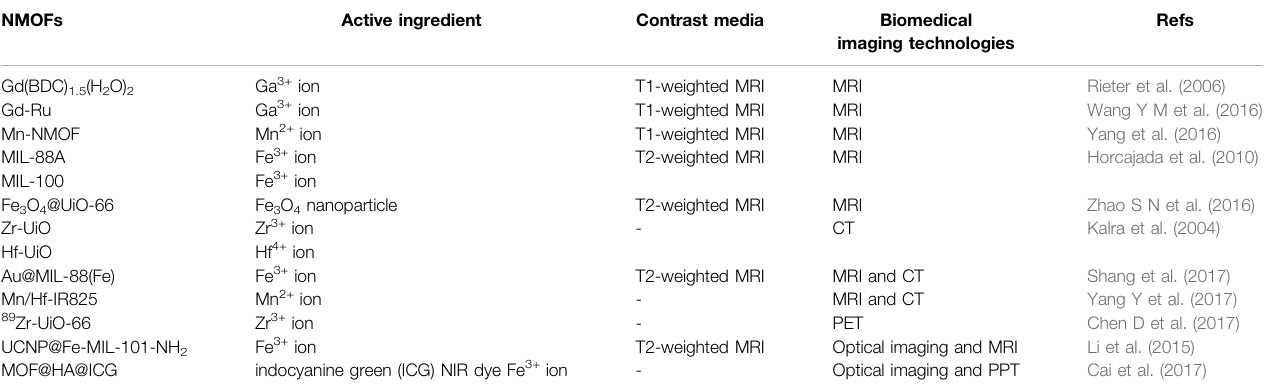
TABLE 4 | Various NMOFs as contrast agents for biomedical imaging.